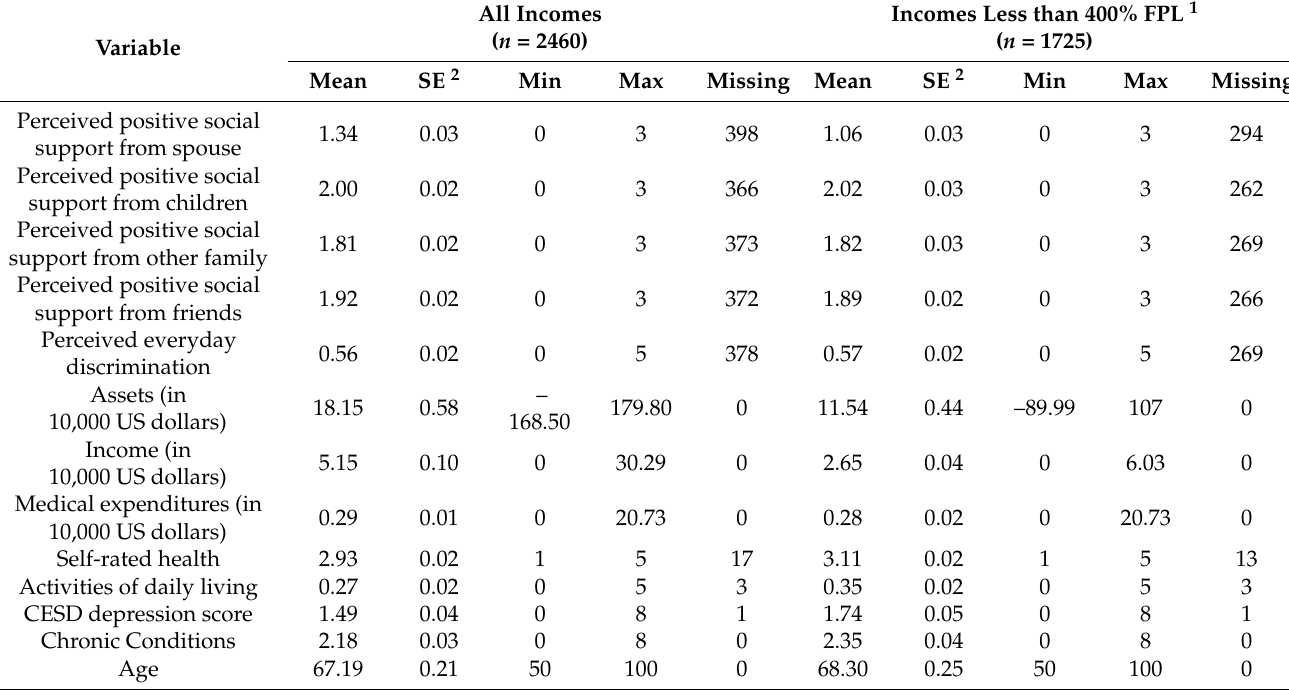
Table 2. Descriptive statistics for continuous independent and control variables from Health and Retirement Study used in the regression analysis for individuals with any income ( n = 2460) and individuals with incomes less than 400% FPL ( n =